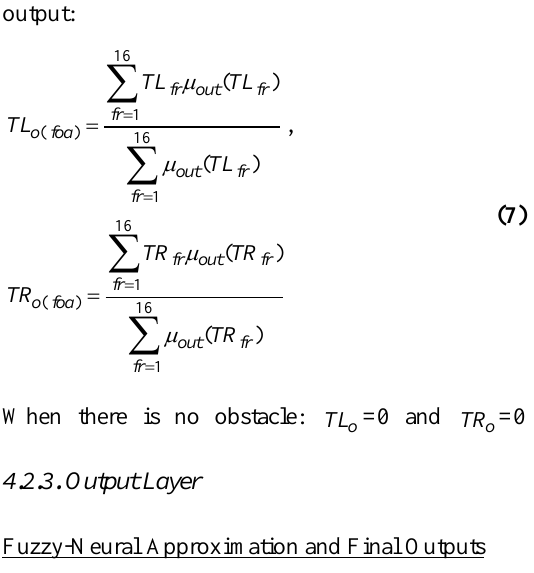
Fig. 12 shows the basic diagram of fuzzy neural approximation of proposed controller. Here the weight functions are approximated by fuzzy sets.